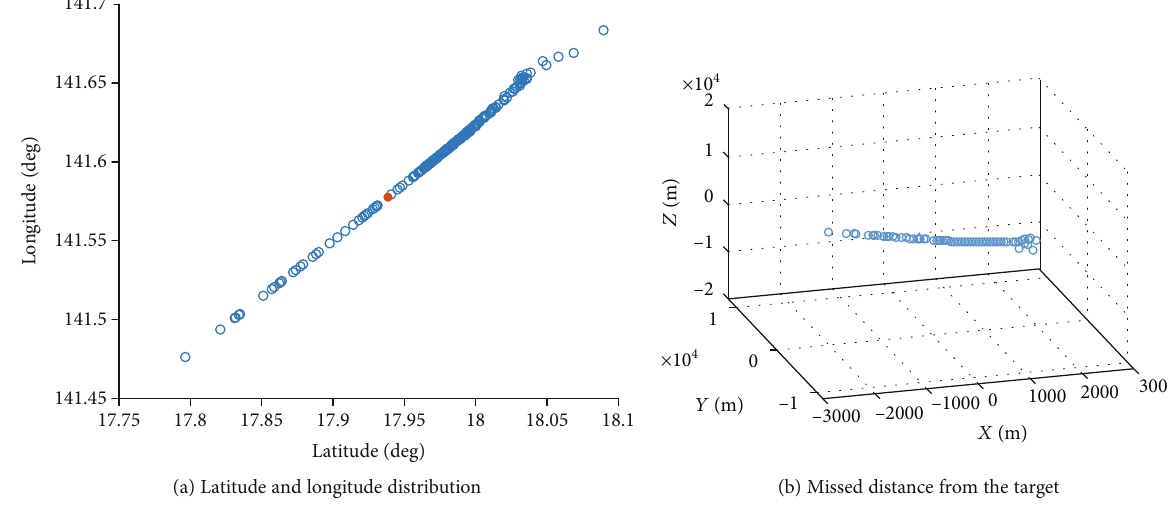
Figure 1: Dataset generation with 500-meter variation in initial position. Table 3: MIC to bank angle for selected training Apollo trajectories.